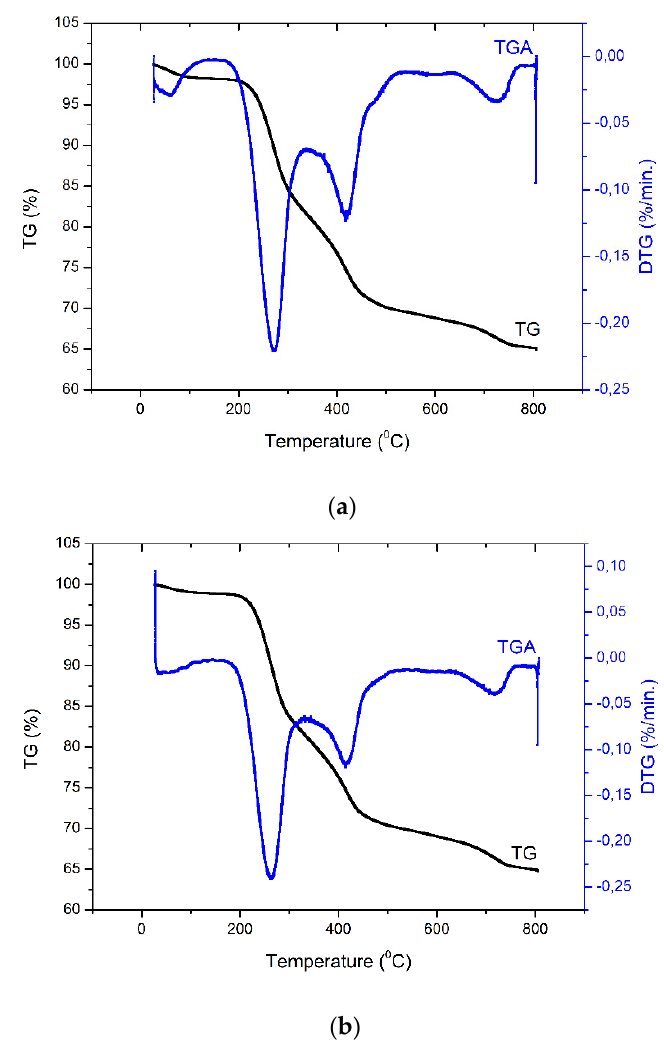
Figure 5. ( a ) Thermogravimetric analysis of ODTMA–clay samples; no MW; ( b ) thermogravimetric Figure 5. (a) Thermogravimetric analysis of ODTMA–clay samples; no MW; (b) thermogravimetric analysis of ODTMA–clay samples with MW analysis of ODTMA–clay samples with MW treatment.